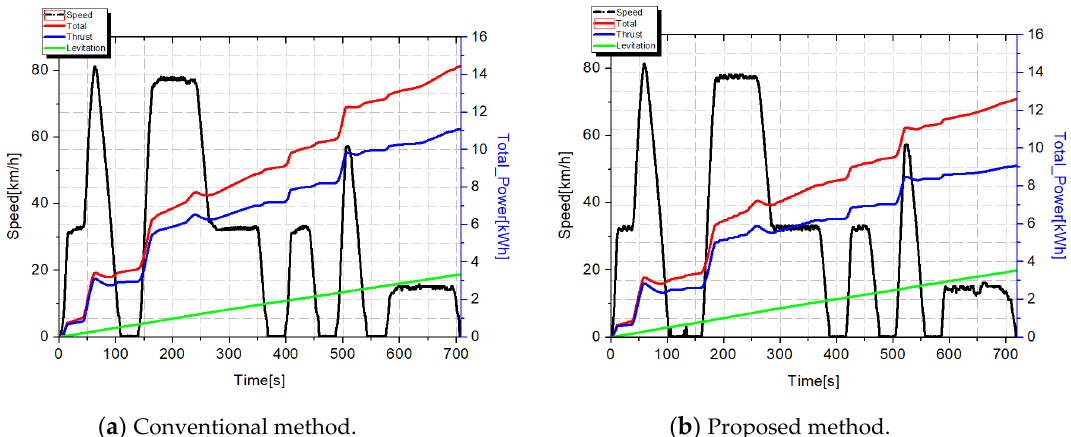
( a ) Conventional method. ( b ) Proposed method. Figure 10. Comparison of accumulated power consumption of existing and proposed methods (106 → 101): ( a ) Conventional method and ( b ) Proposed method.